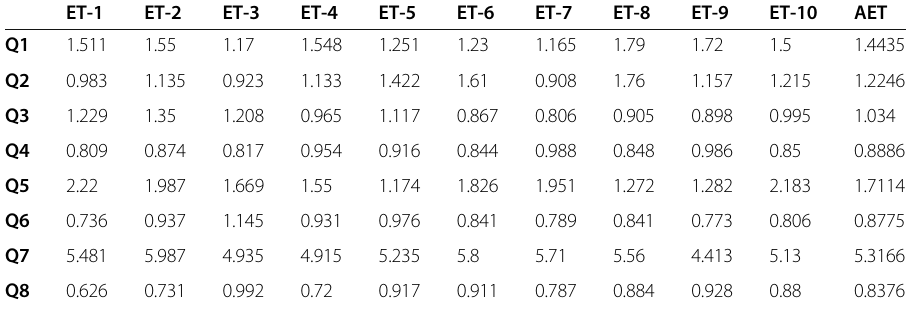
Table 12 Query execution time for Amazon EKS with Colorado State data for HC-1